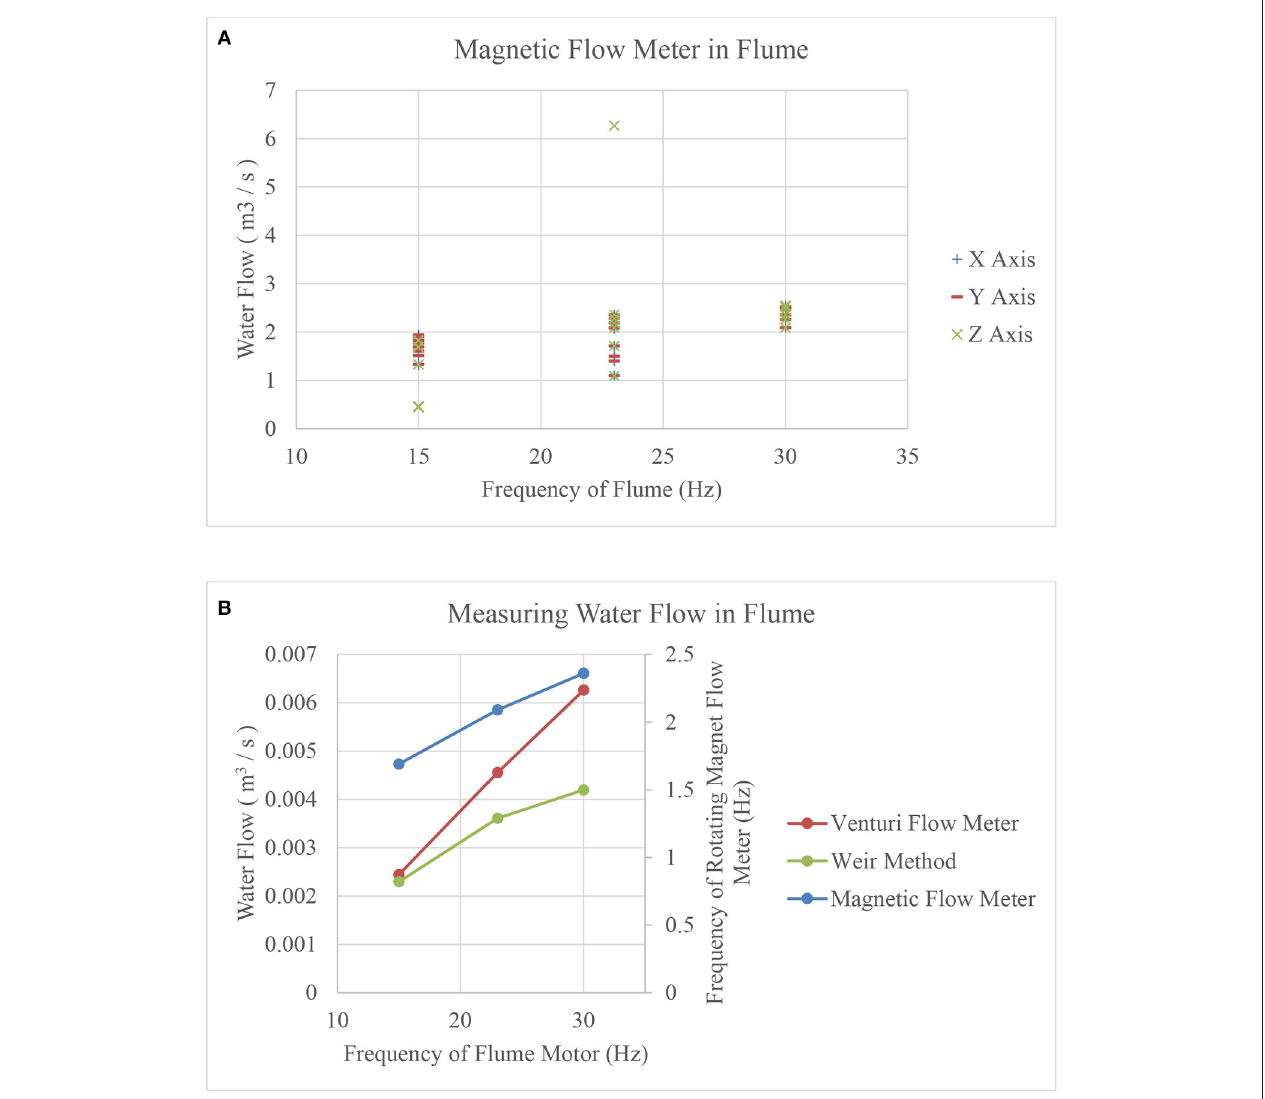
FIGURE 16 | (A) Recorded X, Y, Z axis frequencies of rotating magnet flow meter during flume testing, using IoT system. (B) Median frequency at each flow rate, along with flow measurements using Venturi flow meter and weir